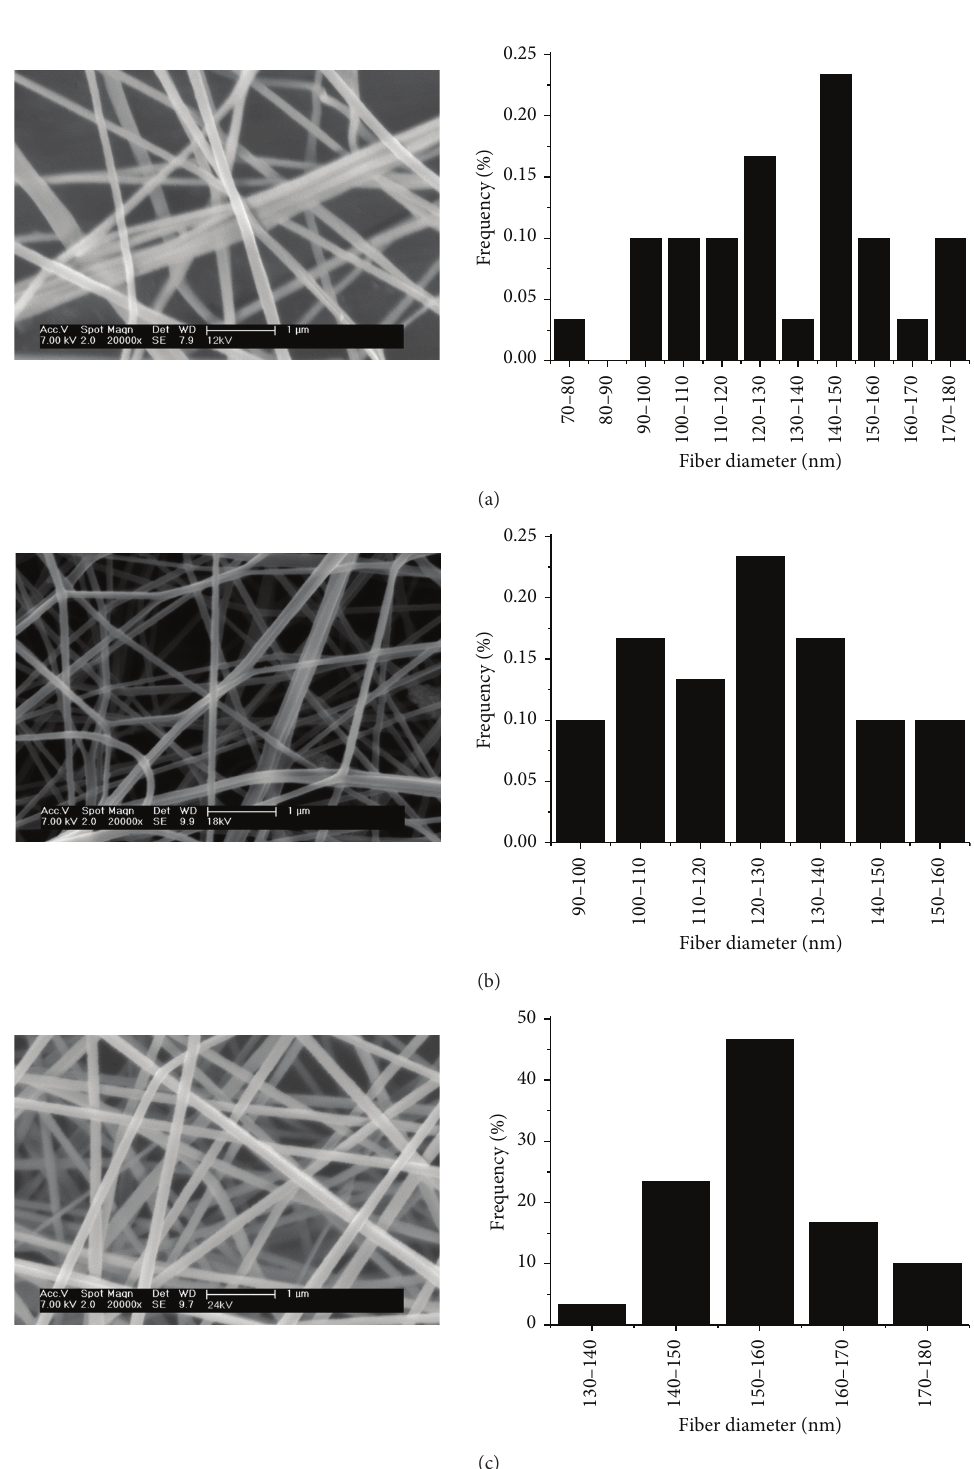
Figure 3: Effect of voltage on fiber morphology and diameter distribution with 1: 1 NaAlg/PEO ratio and 5% solution concentration (magnification = 20,000x). Voltage: (a) 12 kV; (b) 18kV; (c) 24